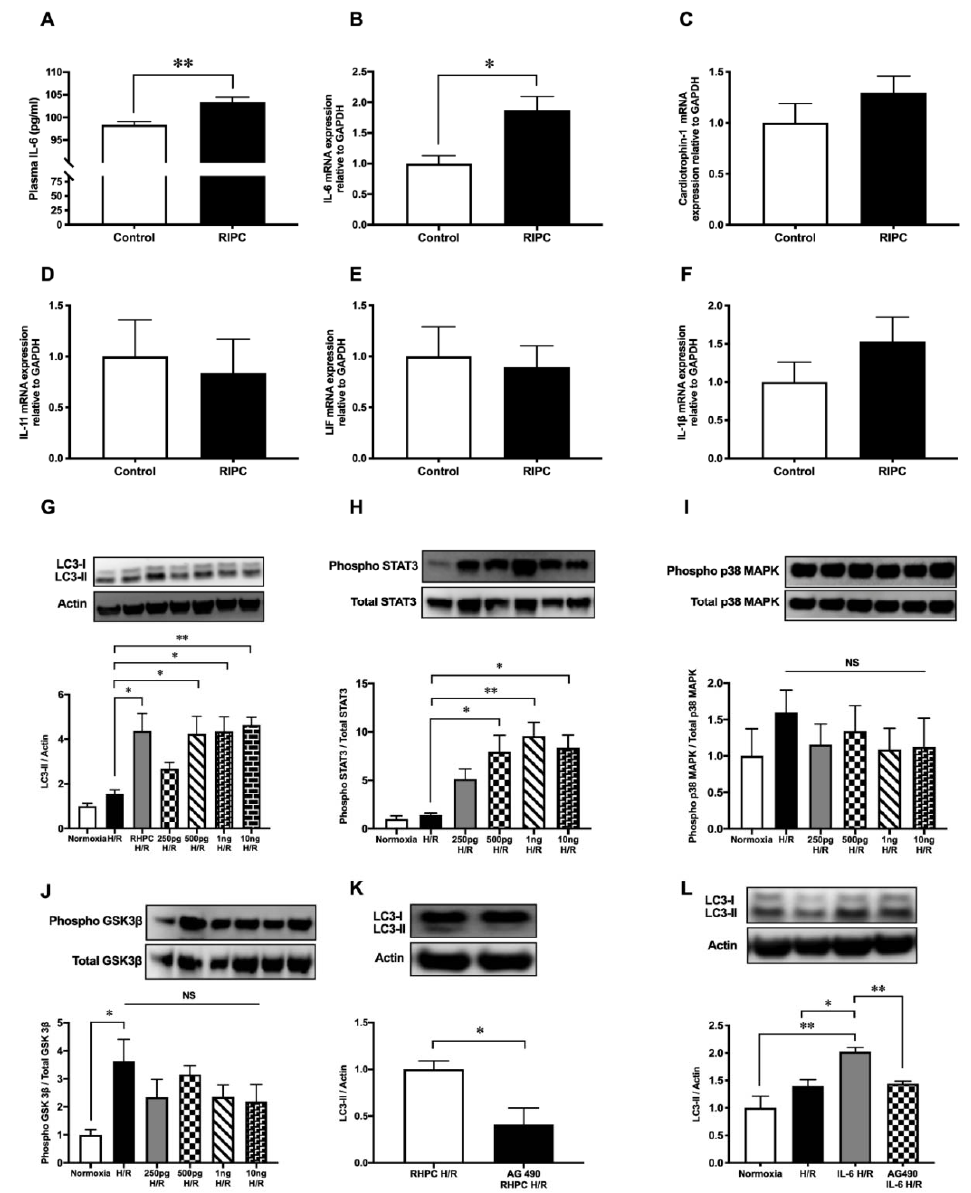
Figure 4. RIPC modulates cytokines’ expression and recombinant IL-6 treatment induces autophagy through the JAK-STAT pathway. ( A ) Plasma IL-6 protein levels at 0 min post-RIPC expressed as mean ± SEM, n = 5, p < 0.01. mRNA expression of ( B ) IL-6, ( C ) cardiotrophin-1, ( D ) IL-11, ( E ) LIF, and ( F ) IL-1 β in rat hind limb muscle at 0 min post-RIPC assessed by qPCR and expressed as mean ± SEM; n = 9, * p < 0.05. Western blot analysis of ( G ) LC3, ( H ) phosphorylated STAT3, ( I ) phosphorylated GSK-3 β , and ( J ) phosphorylated p38 MAPK in H9c2 cells pre-treated with different concentrations of IL-6 (250 pg / mL, 500 pg / mL, 1 ng / mL, 10 ng / mL) during hypoxia followed by reoxygenation. The expression levels of phosphorylated proteins were normalized to total STAT3, GSK-3 β , and p38 MAPK, respectively. Results are expressed as mean ± SEM; * p < 0.05, ** p < 0.01. H9c2 cells exposed to RHPC-H / R with and without the JAK-STAT pathway inhibitor tyrphostin AG-490. Representative immunoblots and statistical data of ( K ) LC3 protein are expressed as mean ± SEM, fold relative to the RHPC-H / R group. ( L ) Representative immunoblot of the LC3 protein level in H9c2 cells with IL-6 treatment during hypoxia with and without tyrphostin AG-490 pre-treatment followed by reoxygenation are expressed as mean ± SEM, fold relative to the normoxic control; n = at least 3 independent experiments, * p < 0.05, ** p < 0.01.